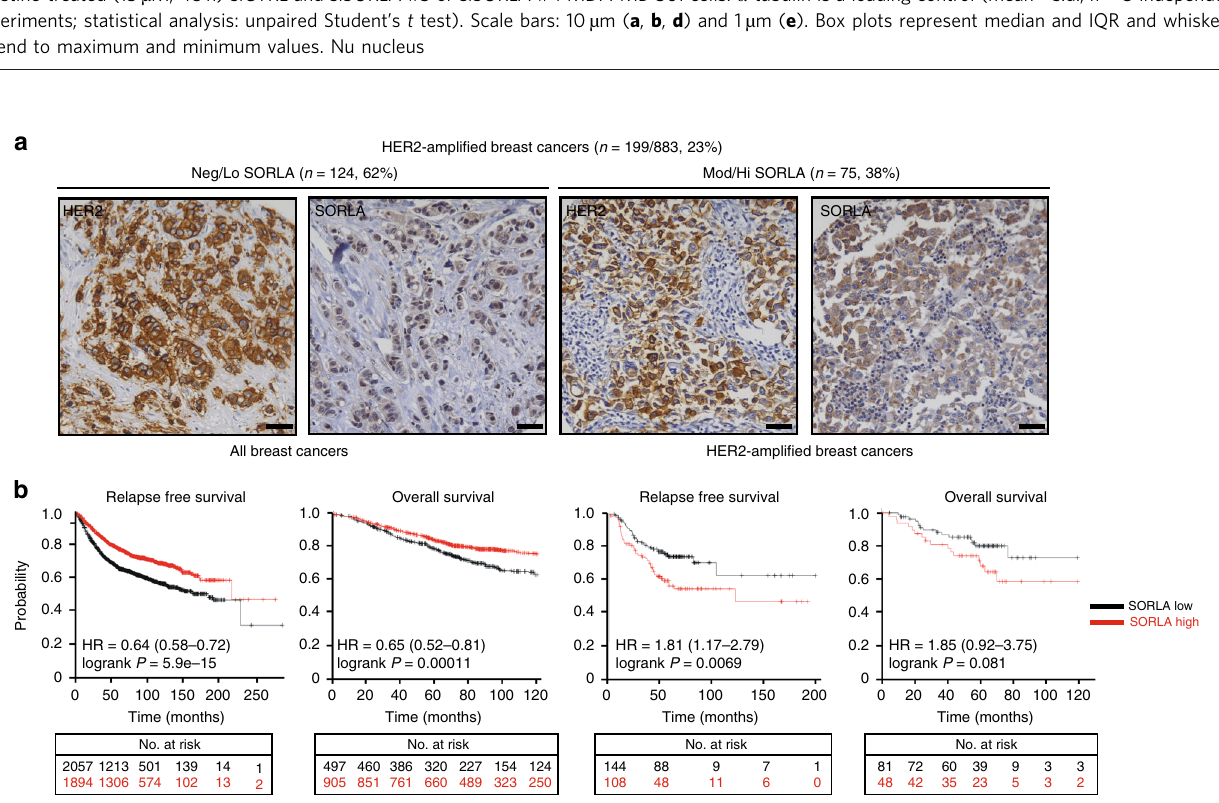
Fig. 5 SORLA has a prognostic value in HER2-ampli fi ed breast cancer. a Immunohistochemical staining of SORLA and HER2 from a breast cancer tissue microarray (TMA; 883 patients in total). HER2-ampli fi ed tumours (199 patients) were categorized into negative/low (Neg/Lo) (staining intensity 0 – 1) and moderate/high (Mod/Hi) (staining intensity 2 – 3) groups. Numbers indicate staining intensity, 0 = negative, 1 = weak, 2 = moderate, 3 = high. b In silico biomarker assessment tool ((http://kmplot.com); including all datasets from 2010, 2012, 2014, 2017) analysis showing Kaplan − Meier plots of overall survival (OS; 10 years) and relapse-free survival (RFS; 20 years) of SORLA-high and SORLA-low patients (split by the best median cutoff) within all breast cancers (RFS n = 3955; OS n = 1402) and within HER2-ampli fi ed breast cancers (RFS n = 252; OS n = 129). Scale bars: 50 µ